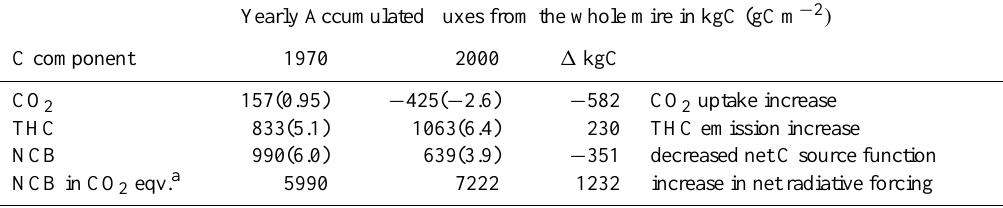
Table 5. Yearly accumulated fluxes for the whole mire in kgC. Within brackets are whole mire area weighted fluxes in gCm − 2 . The calculations are based on flux estimates from this study and area estimates from Johansson et al., 2006. Yearly Accumulated fluxes from the whole mire in kgC (gCm − 2 ) C